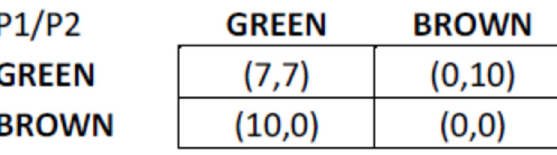
Figure 1. Earning structure of the Game. [ Note : units are ECUs that were later converted to